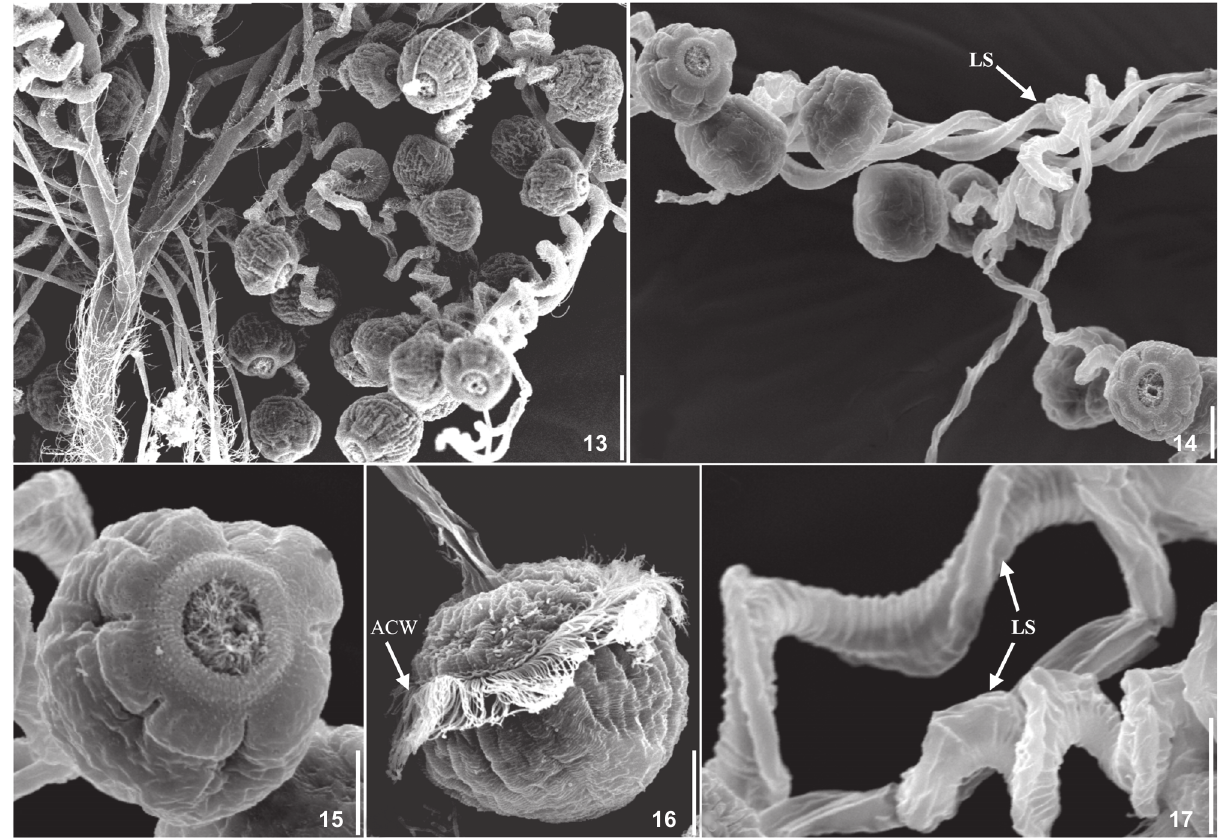
Figures 13-17. Scanning electron micrographs of the Brazilian strain of C. polypinum attached to P. figulina . (13) Colony of C. polypinum . (14) Zooids of C. polypinum showing the lateral stalk (LS). (15) Frontal view of C. polypinum . (16) Lateral view of C. polypinum showing the aboral ciliary wreath (ACW). (17) Lateral stalk (LS). Bars: (13) 100 µm, (14) 50 µm, (15-17) 25